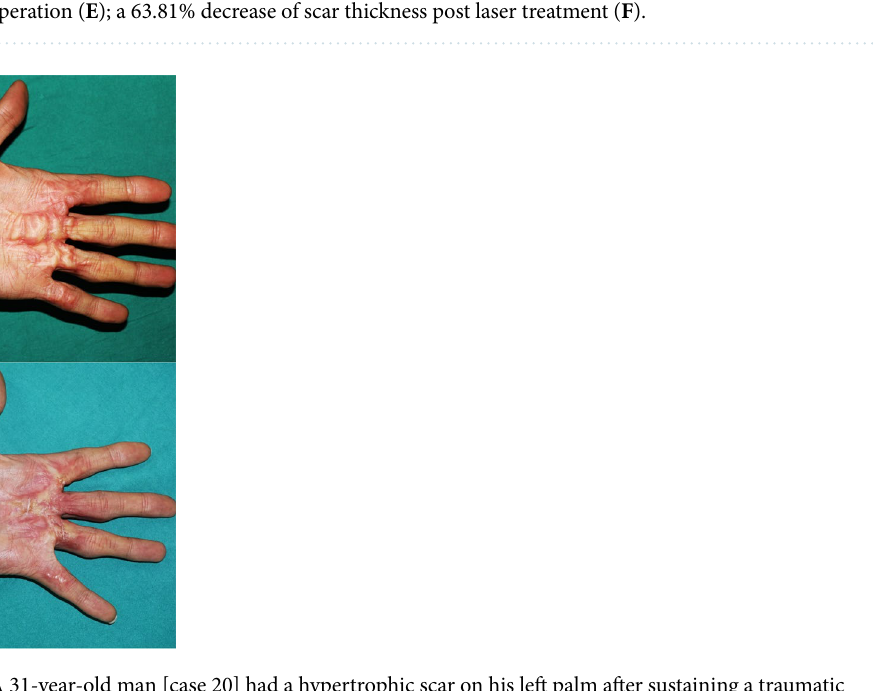
Figure 1. A 9-year-old boy [case 3] with a hypertrophic scar on his back prior laser treatment ( A ); 6 months post two laser therapy sessions ( B ); the scar blood perfusion showed 140.86 Units prior to treatment ( C ), a 32.64% reduction of the blood supply to the scar post laser treatment ( D ); the average thickness was 1.05 cm before the operation ( E ); a 63.81% decrease of scar thickness post laser treatment ( F ).